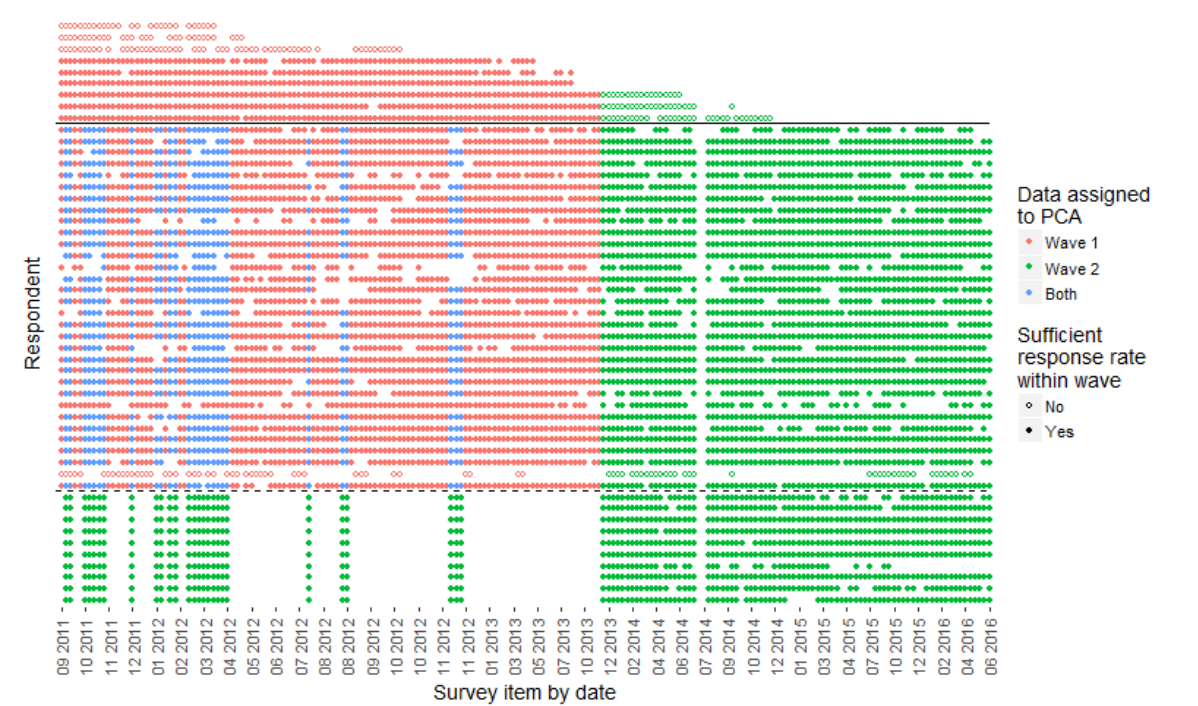
Figure 2: Nonresponse, attrition, and implicit survey waves in the IGM panel. Note: Each point represents a valid response; empty locations indicate nonresponse. Red points represent data analyzed as wave 1. Green points represent data analyzed as wave 2. Blue points were used in both analyses. These items were retroactively posed to the replenishment respondents when they joined the panel. Hollow points represent valid data that could not be used due to an insufficient response rate within that wave. Respondents positioned between the solid and dotted black lines were included in both waves (i.e., their latent ideology is observed twice), unless the respondent did not maintain a 60 percent response rate. In July–September 2014, the panel “revisited” earlier items; items that replenishment respondents had already answered were